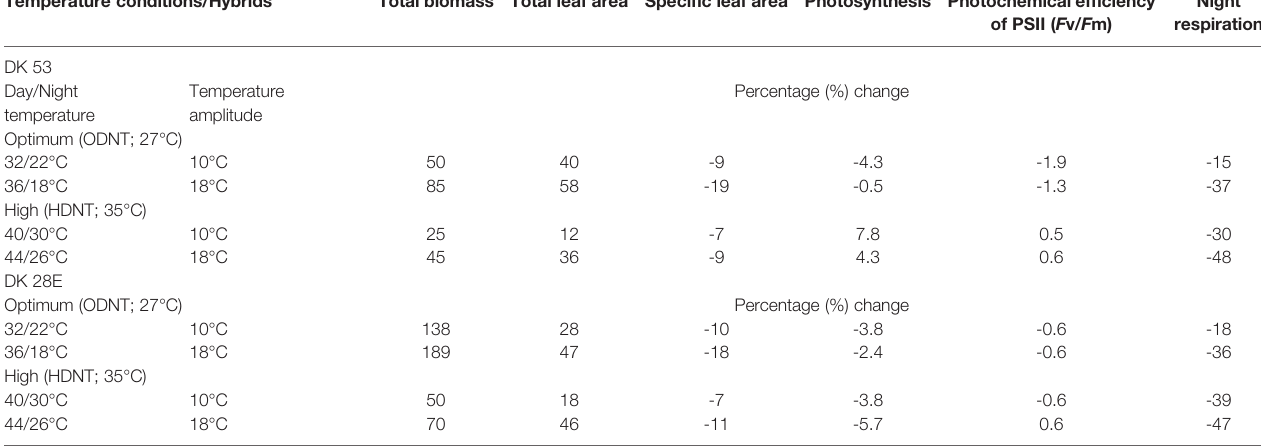
Values in each column are mean of percentage change of two